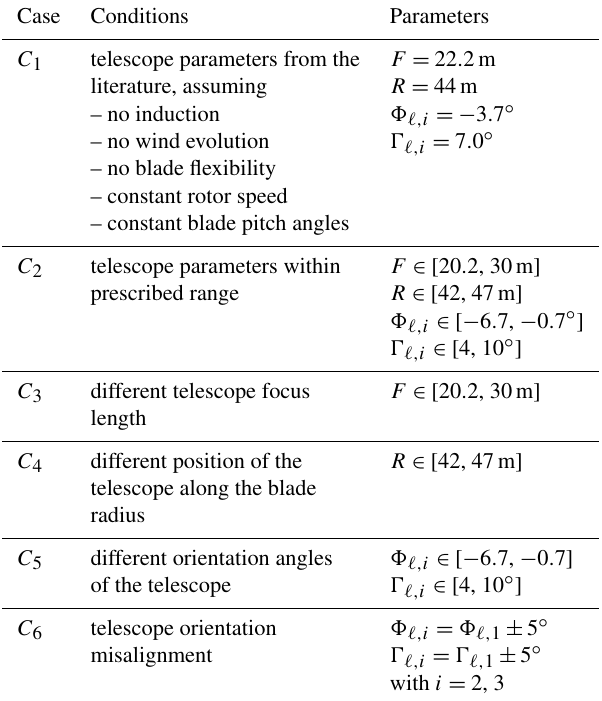
Table 1. The cases investigated in this study, along with the lidar and telescope parameters for each case. If one or more parameters in the third column are not specified, then the parameters defined in the first case are used. F is the focus length, R is the radial position of the telescope along the blade, and (cid:56) (cid:96),i and (cid:48) (cid:96),i are the orientation angles of the telescope (see Fig.